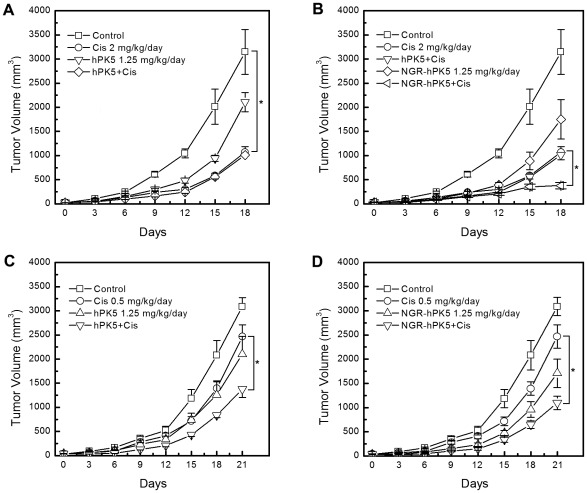
Tumor growth suppression in C57BL/6J mice bearing LLC tumors treated with hPK5/NGR-hPK5 and cisplatin.When the tumor size reached about 50 mm3, the mice were injected i.p. every other day with hPK5/NGR-hPK5 (on days 0, 2, 4, 6, 8 and 10; 6 times totally) and 24 h after each treatment mice were injected i.p. with cisplatin (on days 1, 3, 5, 7, 9 and 11; 6 times totally). The dose of hPK5 or NGR-hPK5 was 1.25 mg/kg/day in all protein therapy groups. Control mice were treated with injections of PBS. A
, hPK5 combined with 2 mg/kg/day of cisplatin; B
, NGR-hPK5 combined with 2 mg/kg/day of cisplatin; C
, hPK5 combined with 0.5 mg/kg/day of cisplatin; D
, NGR-hPK5 combined with 0.5 mg/kg/day of cisplatin. Tumor volume was calculated by the formula (L×W2×0.52). Eight to ten LLC tumor-bearing mice were used in each sample unit, and the data shown were the mean volume ± SE. * p<0.05.